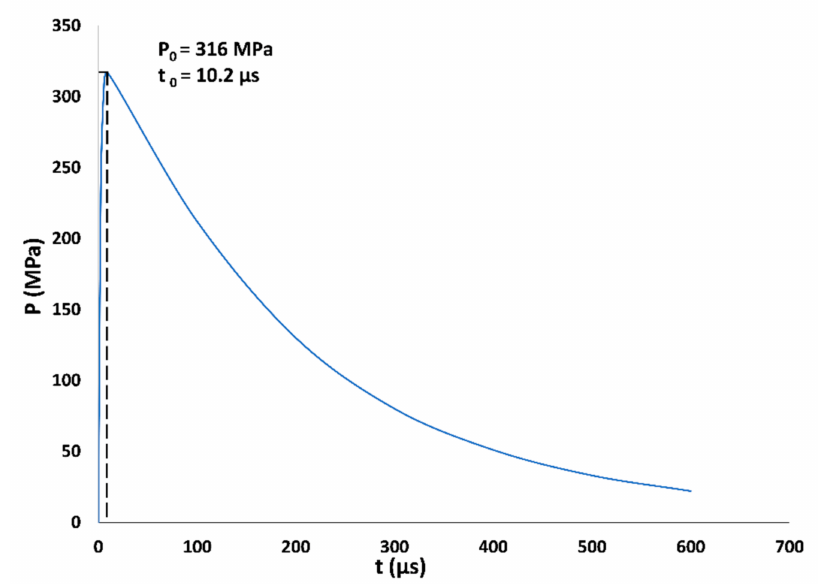
Figure 7. Pressure–time curve of blasting load